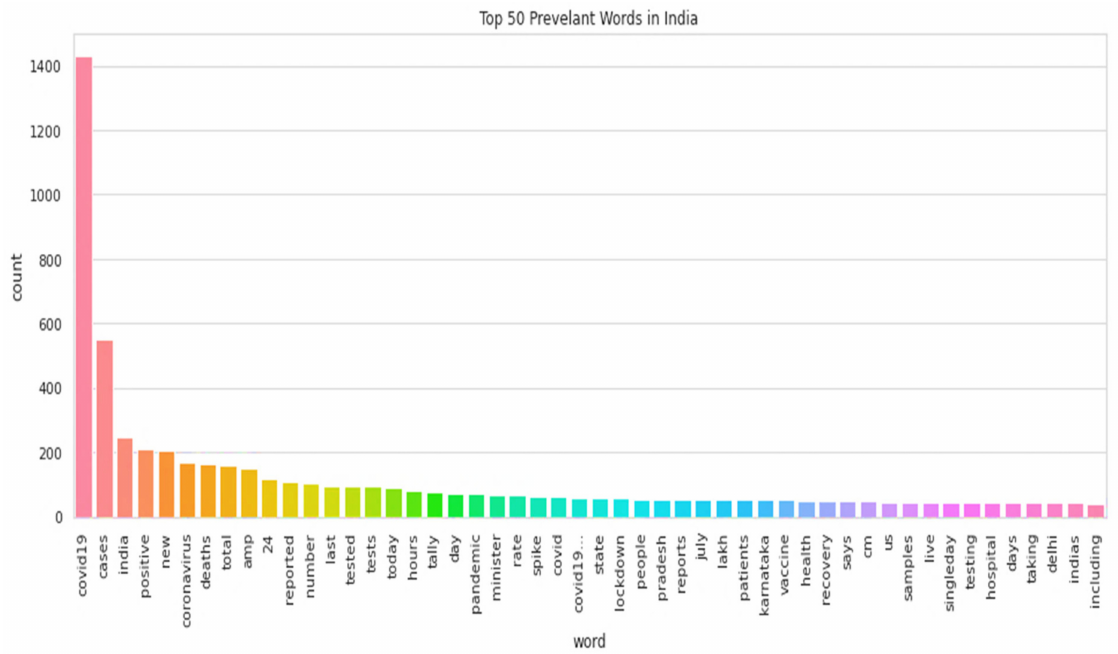
Figure 4. Top 50 keywords that appeared in Indian